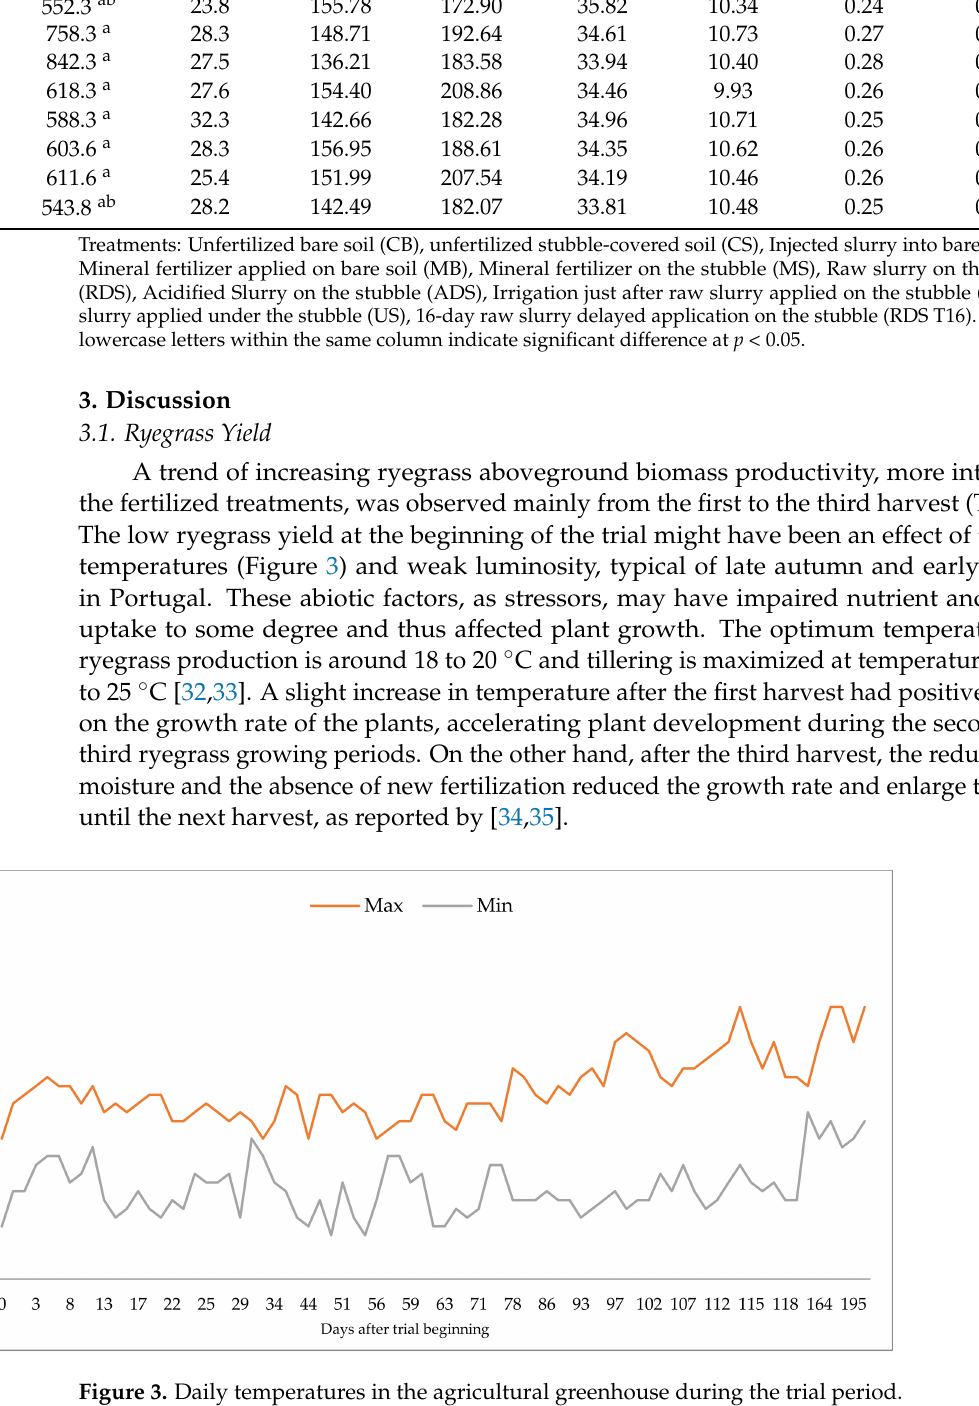
Figure 3. Daily temperatures in the agricultural greenhouse during the trial